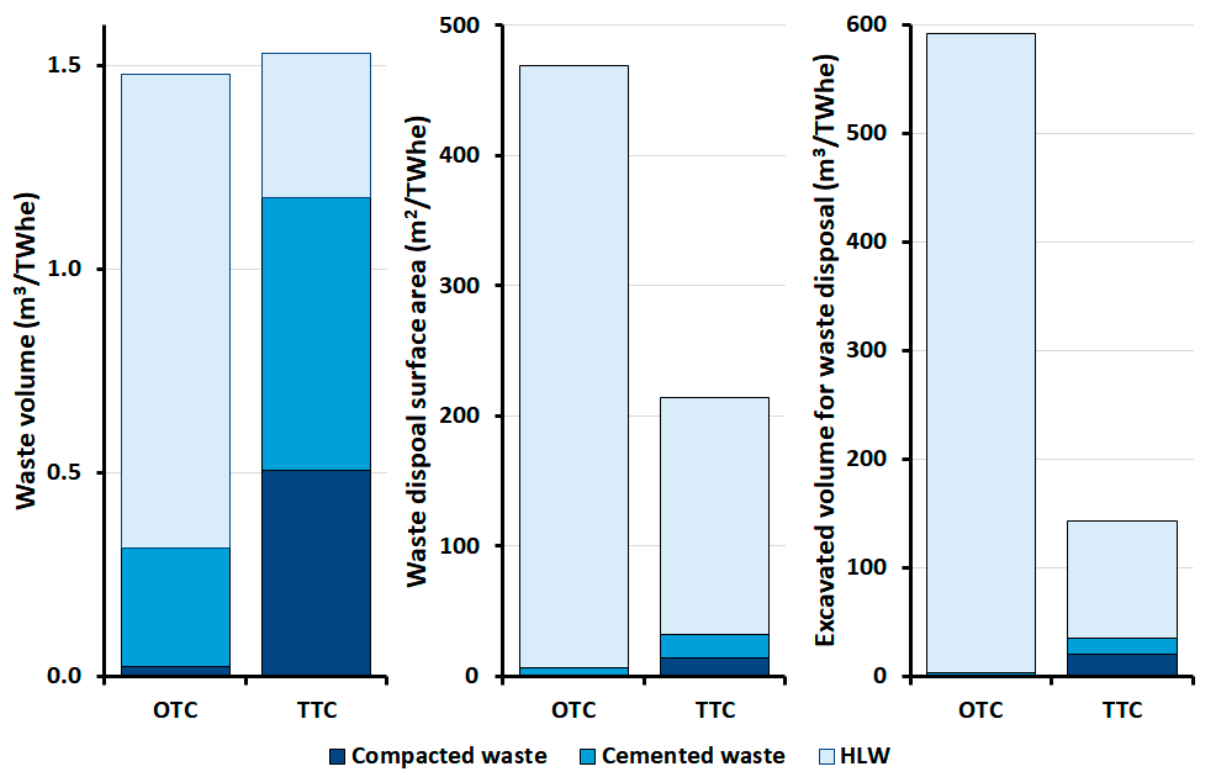
Figure 8. Comparison of the waste volumes, waste disposal surface areas and waste disposal excavated volumes for the TTC and the OTC. Redrawn from data in [50].